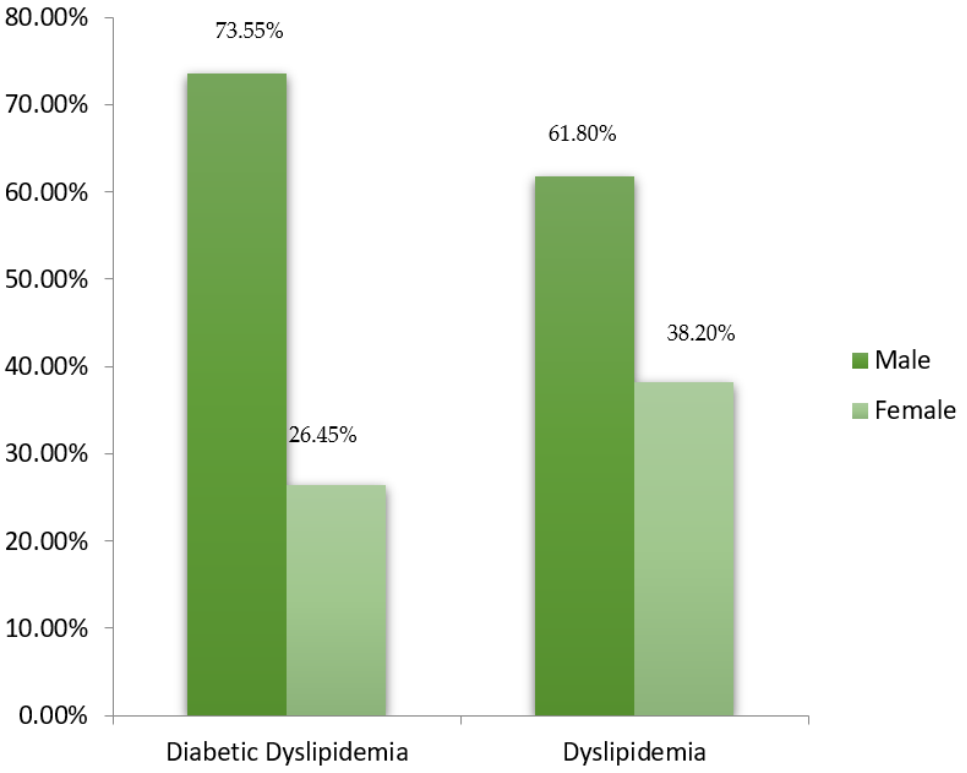
Figure 1. A bar graph illustrating the distribution of stratified males and females in the categorized groups.